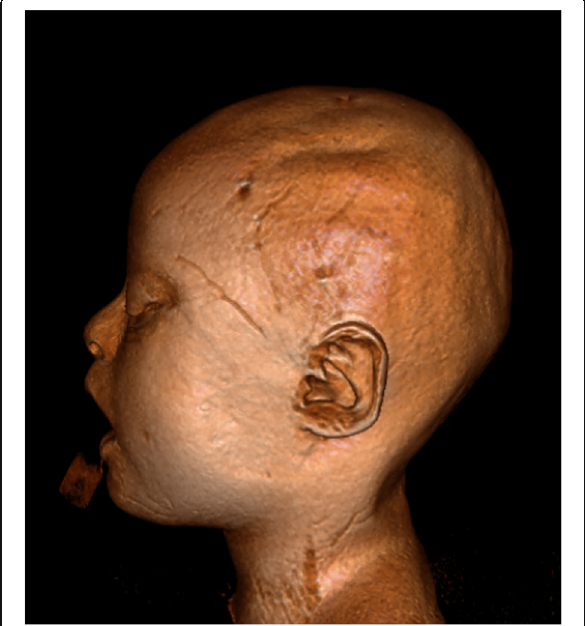
Fig. 2 3D Reconstruction of MR T1/3D in a 5-year-old child with Down syndrome, showing flat occiput with brachycephaly. Note also the small ear with an overfolded helix, which is a common feature of Down syndrome